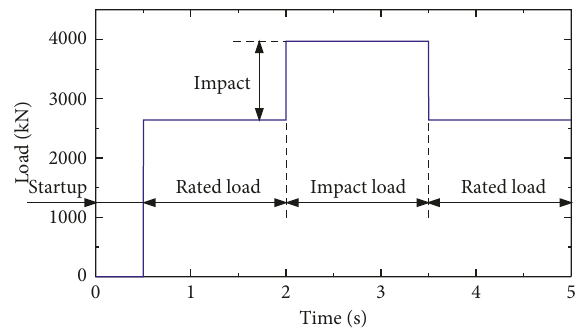
Figure 10: Impact load curve.